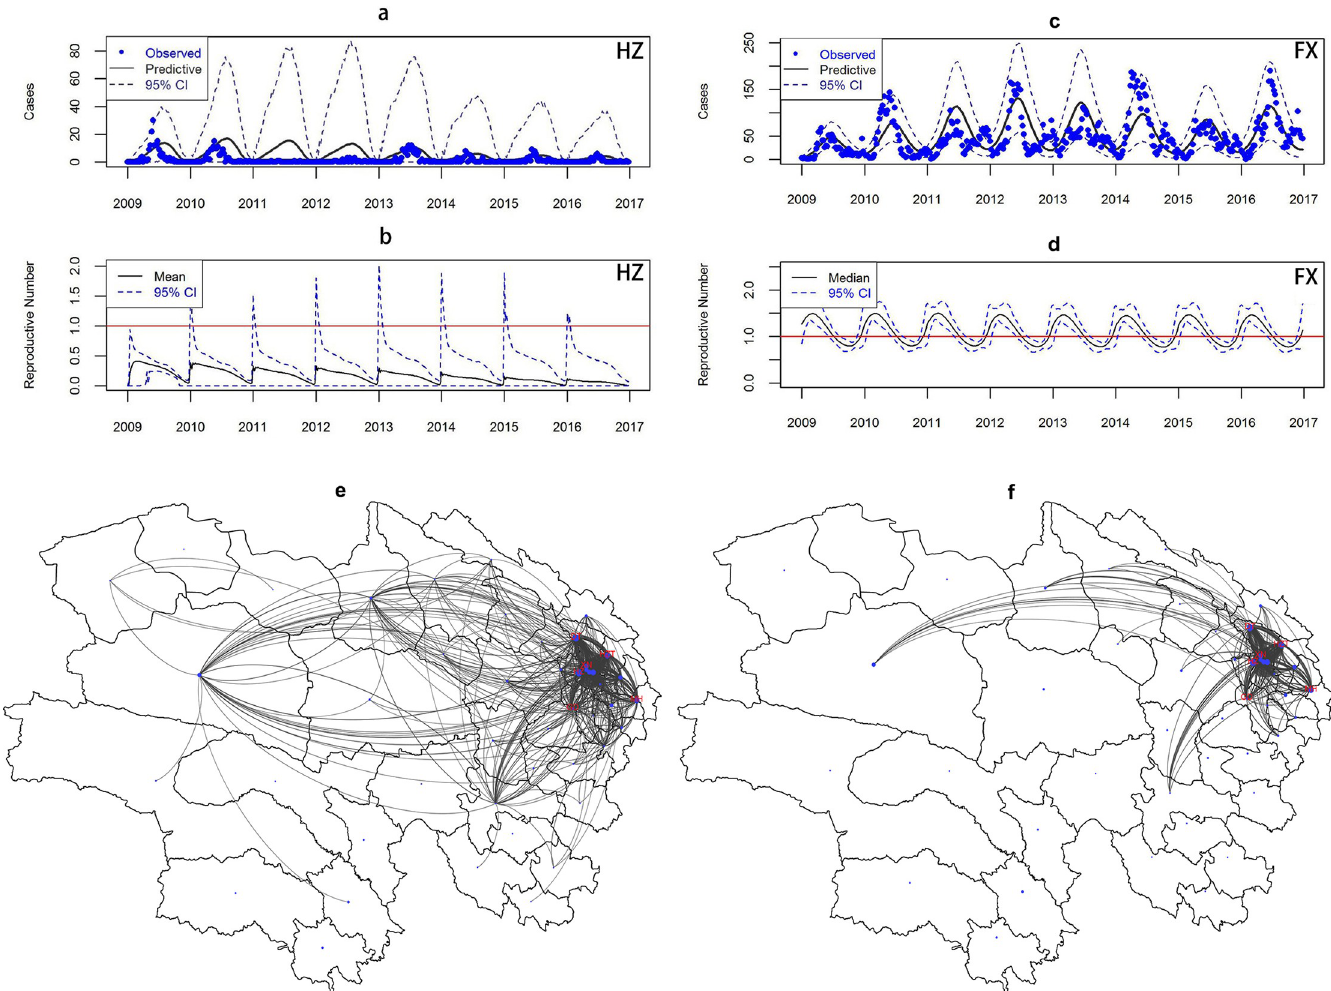
Fig 4. Spatial SEIR fitting results of HFMD transmission. a/c. Posterior predictive distribution for HFMD in Huangzhong and Fengxian. b/d , Empirical adjusted reproductive number of HFMD for Huangzhang and Fengxian. e/f , network of outgoing/incoming infected individuals in Qinghai. HZ = Huangzhong; FX = Fengxian. The map e and f were created using R software (R Development Core Team